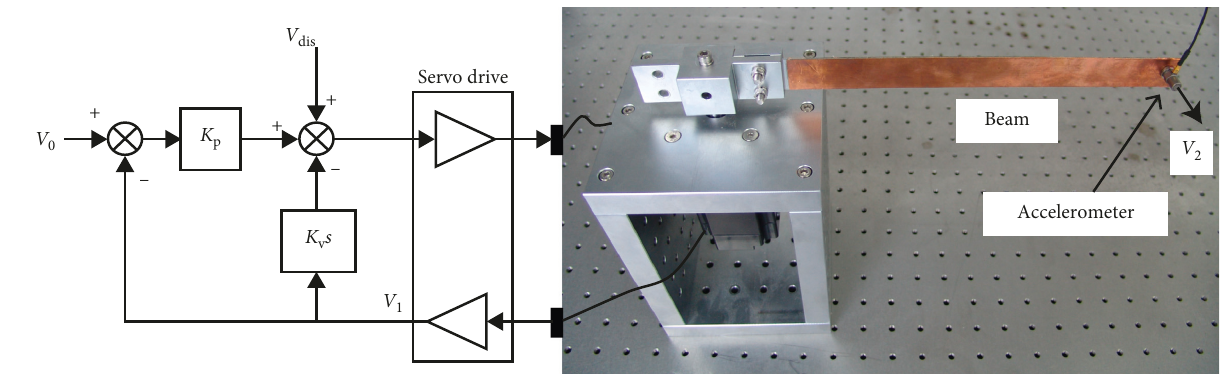
Figure 8: Experimental setup for a PD-controlled servo system driving a single-link flexible beam.